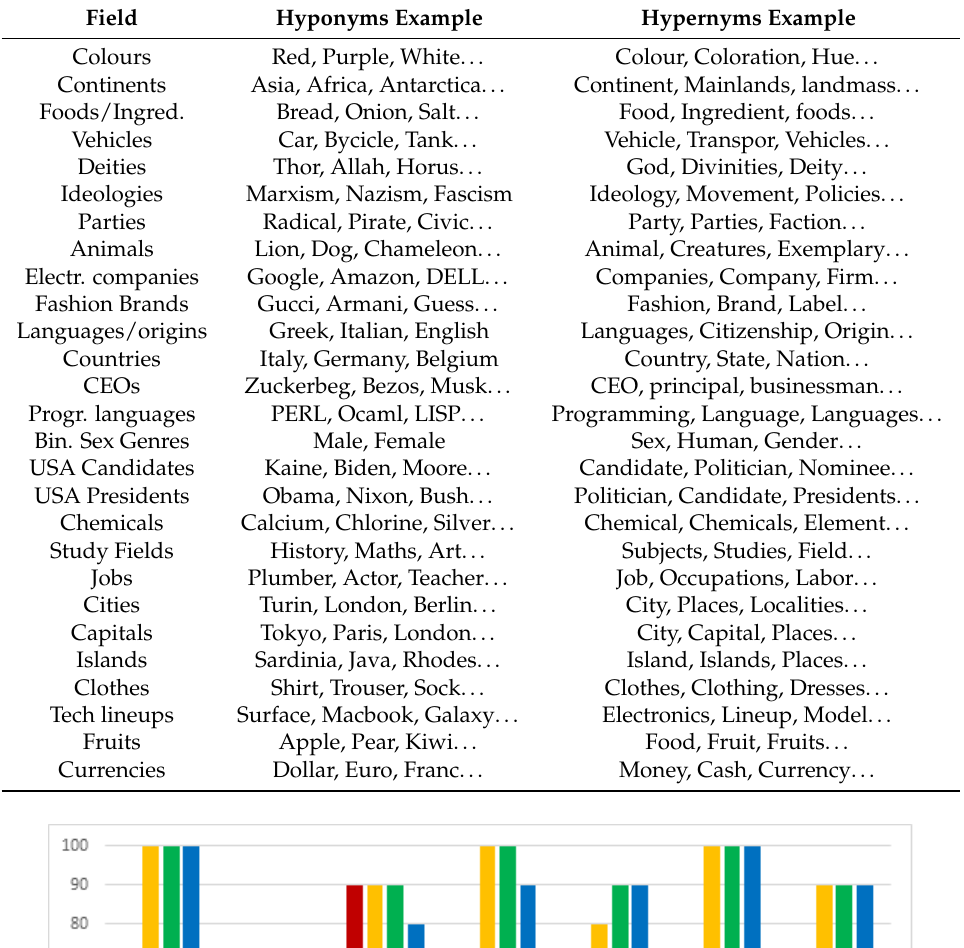
Table 9. Details of the custom testset with some examples.